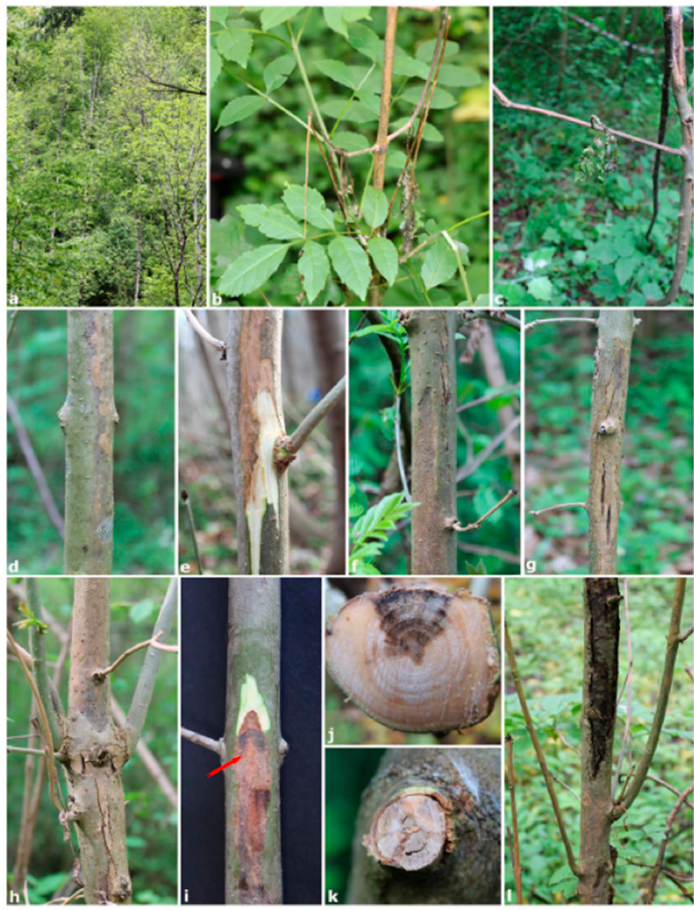
Figure 1. Main disease symptoms detected on European ash trees: extensive canopy dieback ( a ), shoot blight ( b , c ); branches with inner bark discolorations ( d , e ); active sunken cankers on branches with Diplodia fraxini pycnidia (arrow) ( f – i ); cross-section of branches showing wedge-shaped necrotic